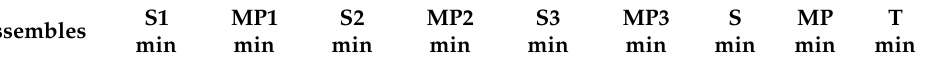
Table 3. Time required for the adjustment of the complementary frameworks, in order to obtain the assembly with the surface of the Pa framework (S1, S2 and S3 are sandblasted time steps in minutes of process, S-total time of sandblasted process, MP1, MP2 and MP3 are the time steps in minutes of mechanical processing process, MP-total time for mechanical processing process, T-total time for adjustment). Assembles